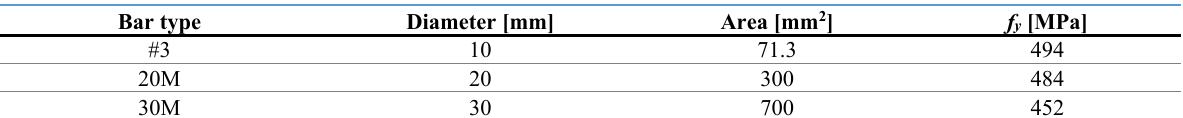
Table 2. Experimental data on the steel bars used in the tests by Sherwood [26]. Where, f y is the yield strength of reinforcement. Bar type